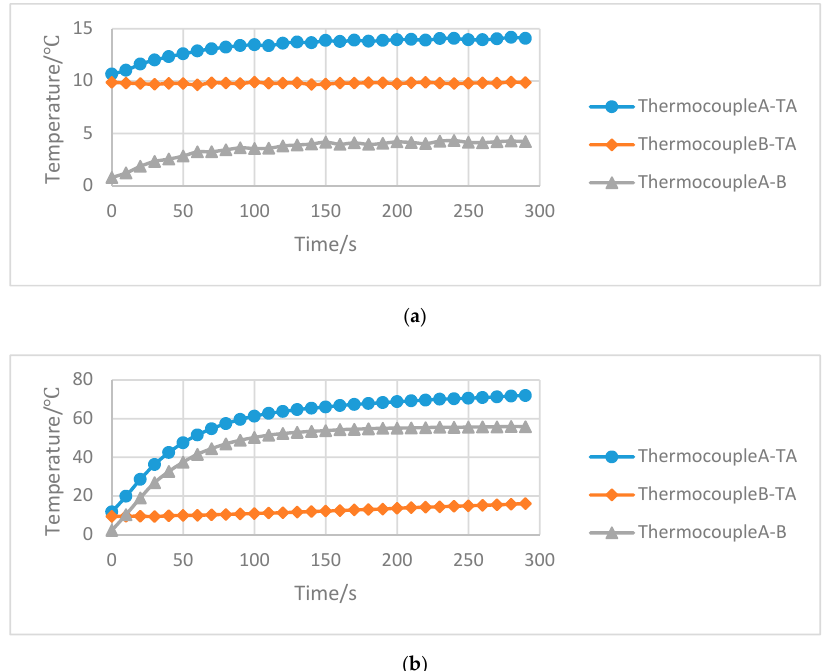
Figure 8. ( a ) Thermocouple temperature and temperature difference at 0.5 A; ( b ) thermocouple temperature and temperature difference at 6 A.